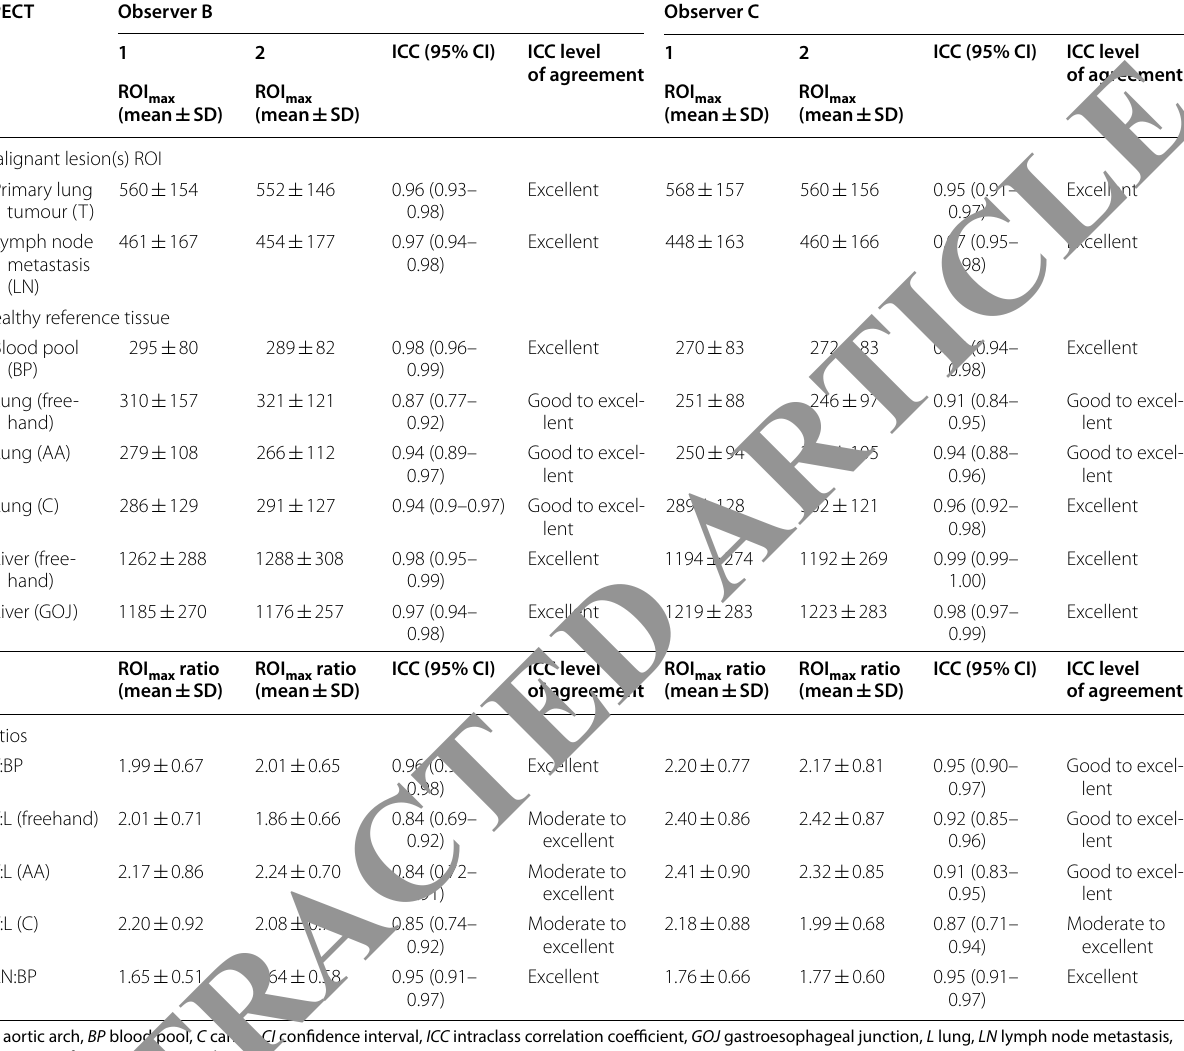
Table 5 Intraobserver agreement. Malignant lesion and healthy tissue reference measurements (ROI mean SD) and their ratios, of observer B and C from two timepoints, with intraclass correlation coefficient (ICC), its 95% ± confidence interval (CI) and descriptive ICC level of